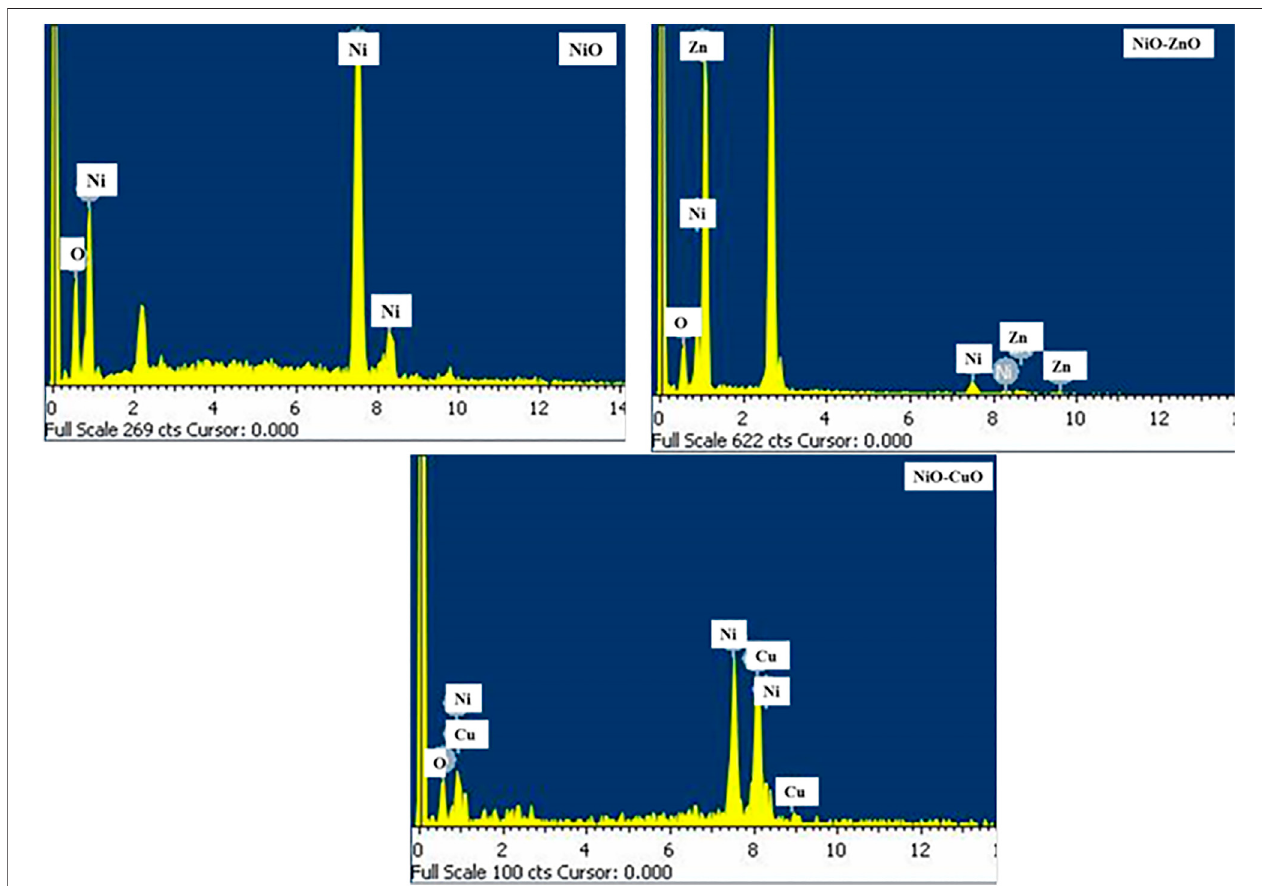
FIGURE 3 | Energy dispersive spectra/EDS/of NiO, NiO-ZnO, and NiO-CuO materials.